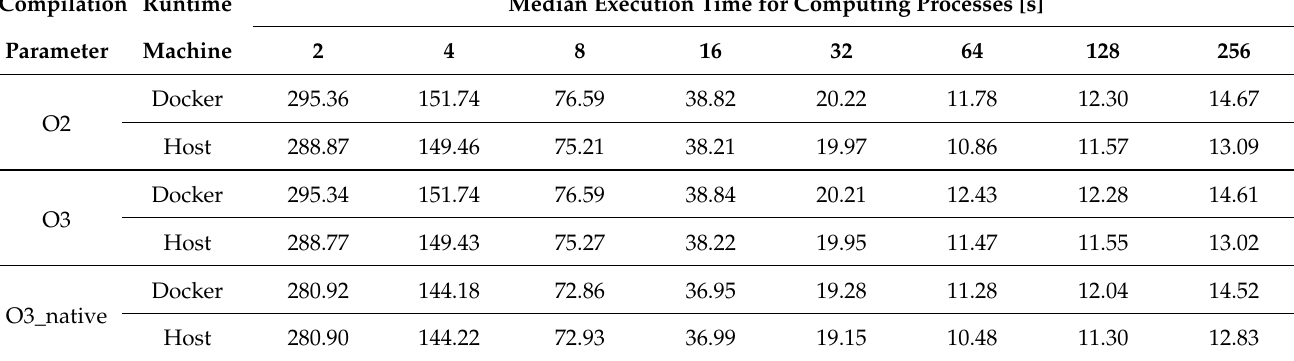
Table 2. Median execution times for MasterSlave.